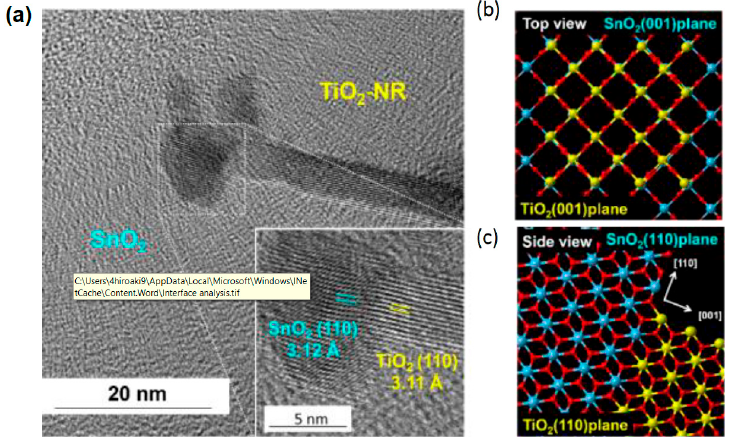
Figure 2. ( a ) TEM image for a particle prepared by the hydrothermal reaction at t HT = 1 h, and the inset is the HR ‐ TEM image for the interface of the same sample. Top view ( b ) and side view ( c ) for the interface model constructed from the HR ‐ TEM image. The figure is taken from Reference [14] (reproduced with permission from Akita, A.; Tada, H., Langmuir ; published by American Chemical Society, 2019).